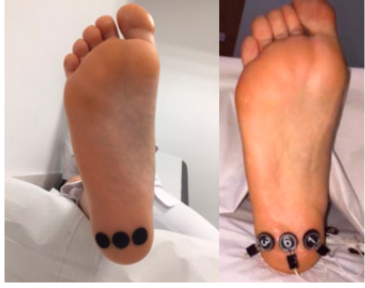
Figure 1. Placing the sensors in the places chosen.